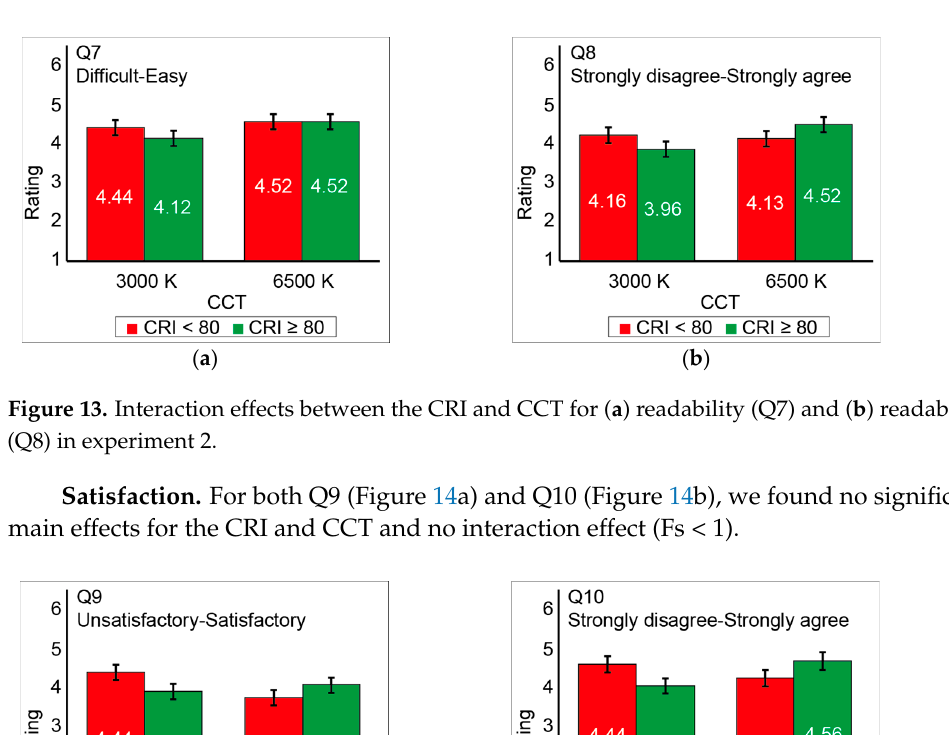
comfort (Q6) in experiment 2.